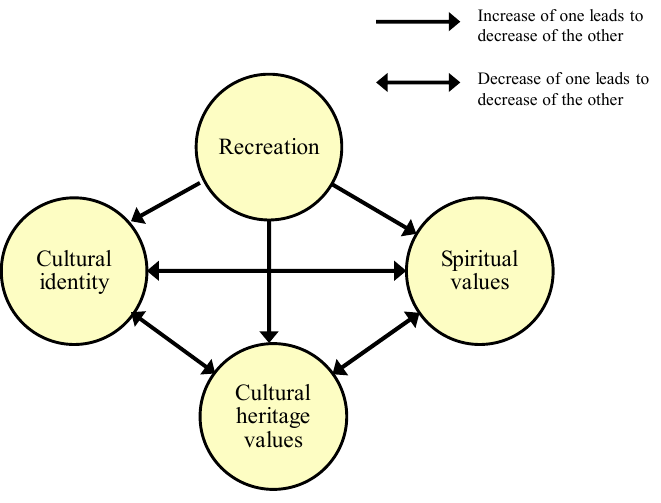
Figure 7. Interrelations between different CES. Source: Own